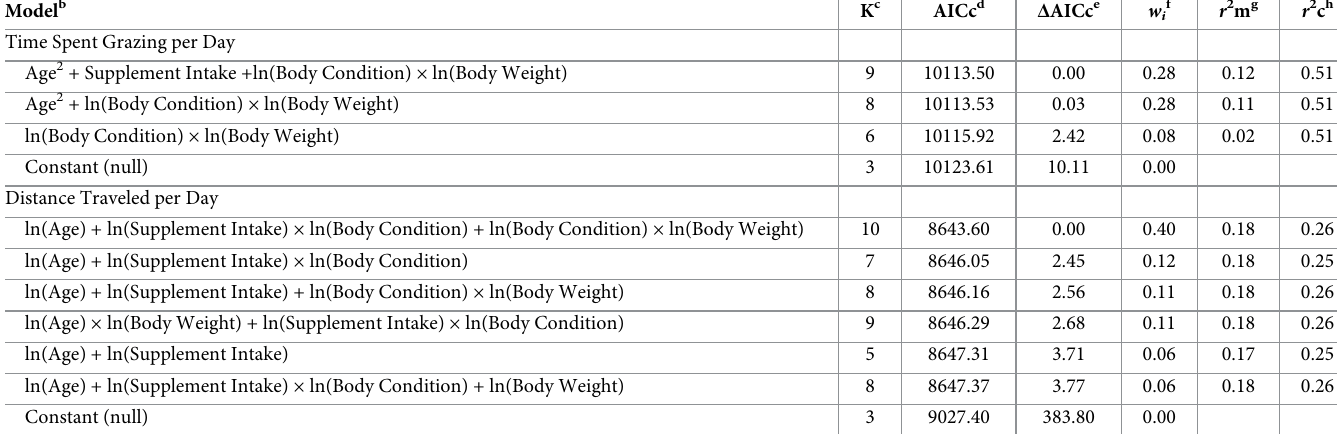
Table 2. Model selection for models evaluating the effects of cow age, body condition and supplement intake on time spent grazing per day (hrs) and distance trav- eled per day (km) by cattle grazing dormant rangeland in 2016 – 2017 & 2017 – 2018 at the Northern Agricultural Research Center Thackeray ranch, Havre, MT. Model